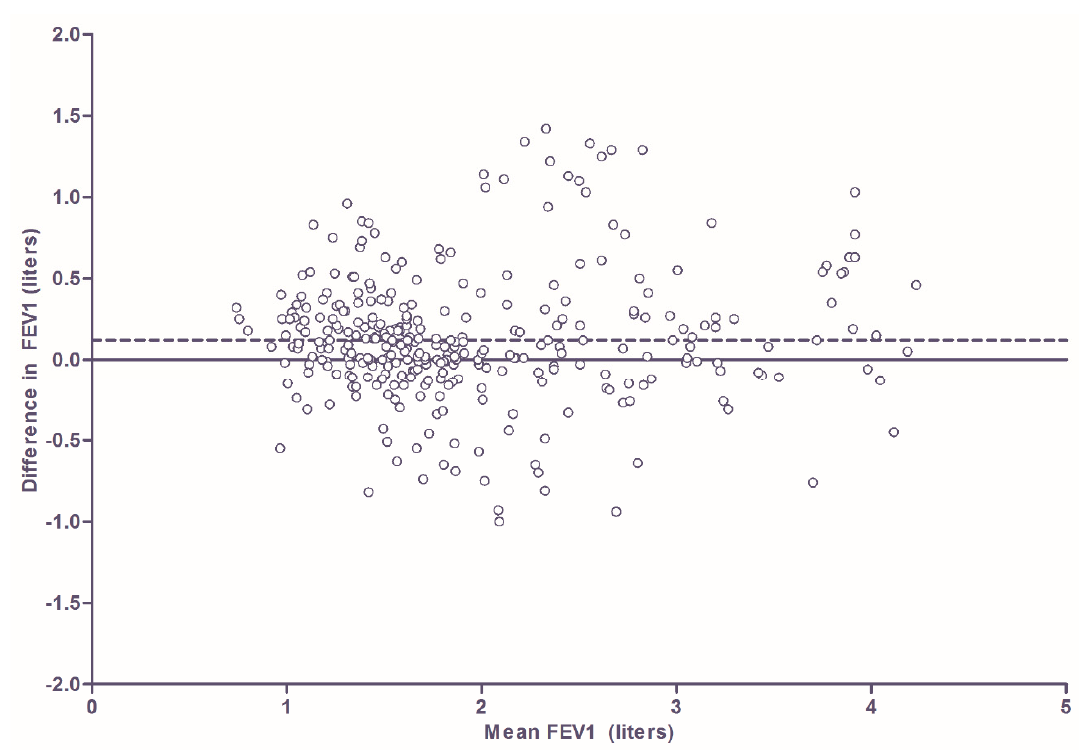
Figure 2. Bland-Altman plot showing degree of agreement between the two types of measurement in patients with asthma. Difference in FEV1 is calculated by subtracting home FEV1 measurement from clinical FEV1 measurement. The dotted line shows the mean difference (0.12 L).